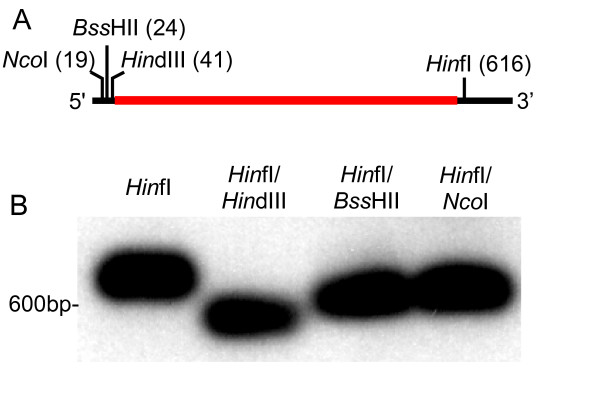
Completeness of the terminal sequences of strain AT chromosome of 'Ca. P. mali'. A: Restriction site prediction of the 5' end of the strain AT chromosome. The PCR generated digoxigenin-labeled probe is displayed in red. B: Southern blot hybridization of strain AT DNA digested with indicated enzymes. The fragment sizes correspond to the restriction sites predicted in the sequence with sizes of 616, 575, 592, and 697 bp for the HinfI (lane 1), HinfI/HindIII (lane 2), HinfI/BssHII (lane 3), and HinfI/NcoI (lane 4) fragments, respectively.